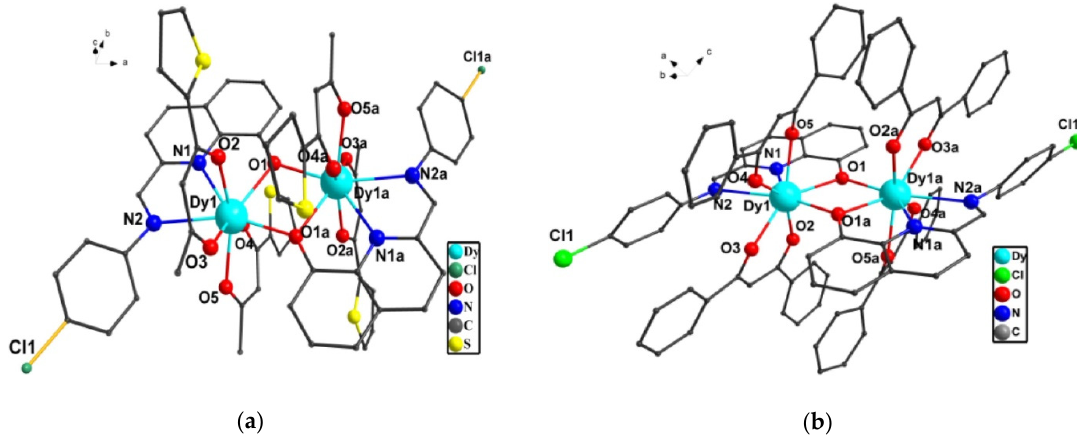
Figure 3. Molecular structures of ( a ) [Dy(TTA) 2 L] 2 ; ( b ) [Dy(dbm) 2 L] 2 . Hydrogen atoms are omitted for clarity; abbreviations are given in the main text. Reprinted from [70], copyright 2020, with permission from Elsevier.